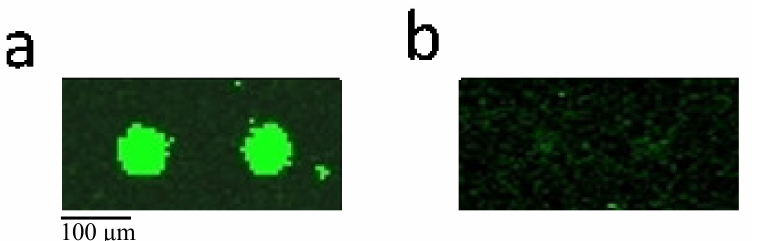
Figure 2. The imaging results of CASK in ( a ) chip of miR-1587 in the G-quadruplex structure ( b ) chip of miR-1587 in free form. The miR-1587 was labeled by FAM and the proteins were fixed on the surface of chips, leading to the acknowledgment that the fluorescence signals indicated the binding between miR-1587 and the protein in a specific area. This figure indicates that CASK could bind to the miR-1587 in the G-quadruplex structure but could not bind to miR-1587 in free